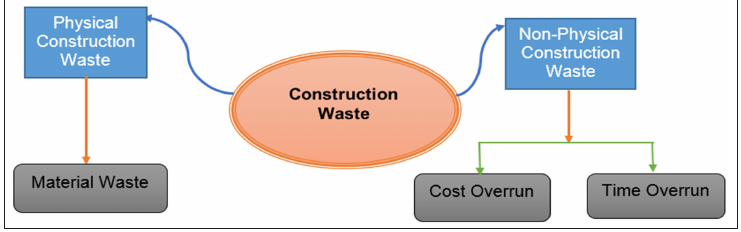
Figure 1: Classification of construction waste Adapted from: Nagapan, Abdul-Rahman & Asmi, 2012: 2 Furthermore, the causes of material waste and those of cost overruns identified from the literature are similar. These causes occur as a result of one, or a combination of several causes at different stages of a project (the pre- and the post-contract stages), and they are crucial in identifying effective cost performance and sustainable construction (Saidu, 2016: